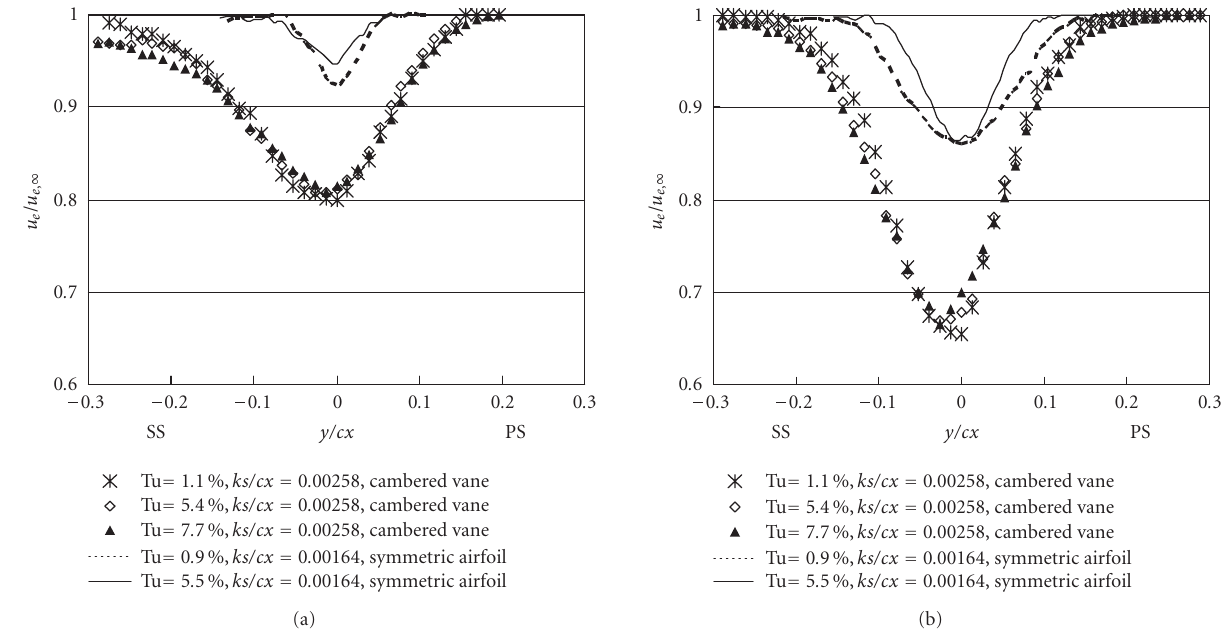
Figure 5: Normalized wake mean velocity distributions measured one axial chord length downstream of the cambered airfoils with di ff erent inlet turbulence intensity levels. (a) Smooth airfoil with ks/cx = 0. (b) Airfoil with big-sized roughness, ks/cx = 0 . 00258.